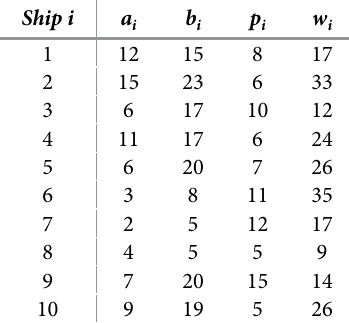
Table 1. Parameters for the